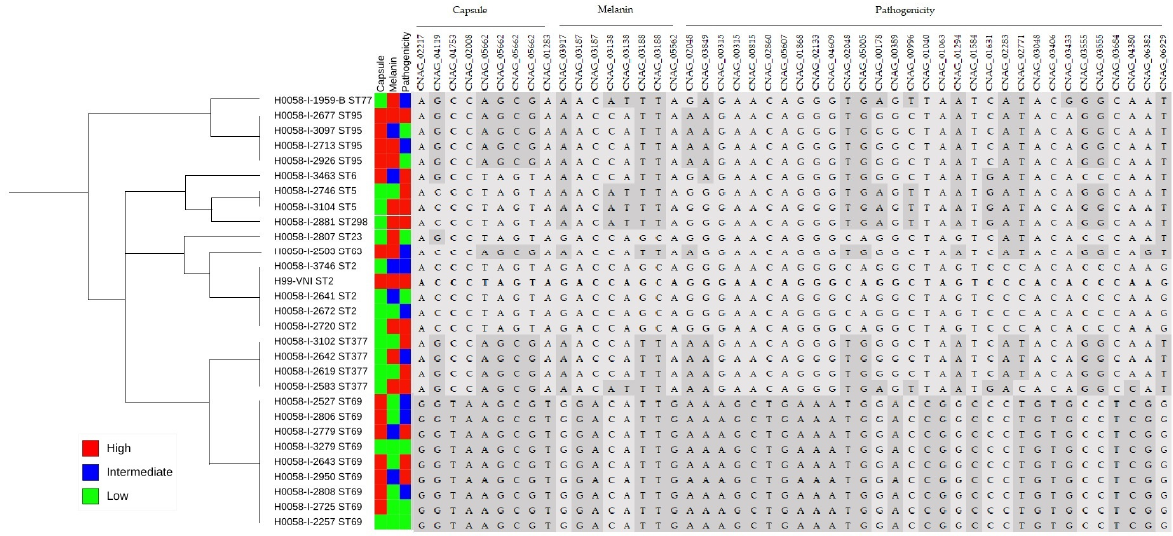
Figure 8. Gene variants associated with phenotypic groups and STs. The reference sequence is in bold (H99). The evolutionary history as inferred from the MLST data was reconstructed via the maximum likelihood method and the Jukes–Cantor model using concatenated nucleotide sequences of 7 loci. From phylogenetic analysis of pathogenicity in G. mellonella , capsule size and melanin production, the 39 genes that grouped the 48 non-synonymous variants identified are shown.